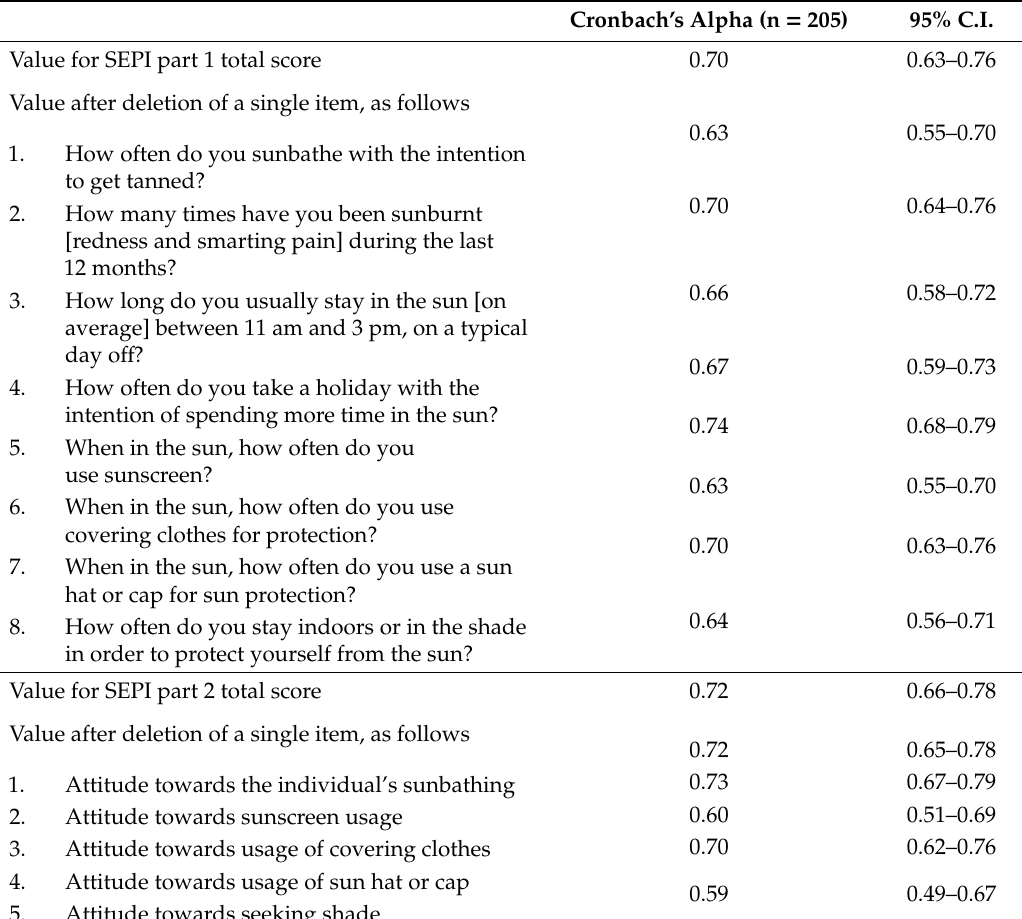
Table 1. Internal consistency of SEPI part 1, in terms of Cronbach’s alpha, and its 95% confidence intervals, displayed for the total score and with deletion of each of the individual items.